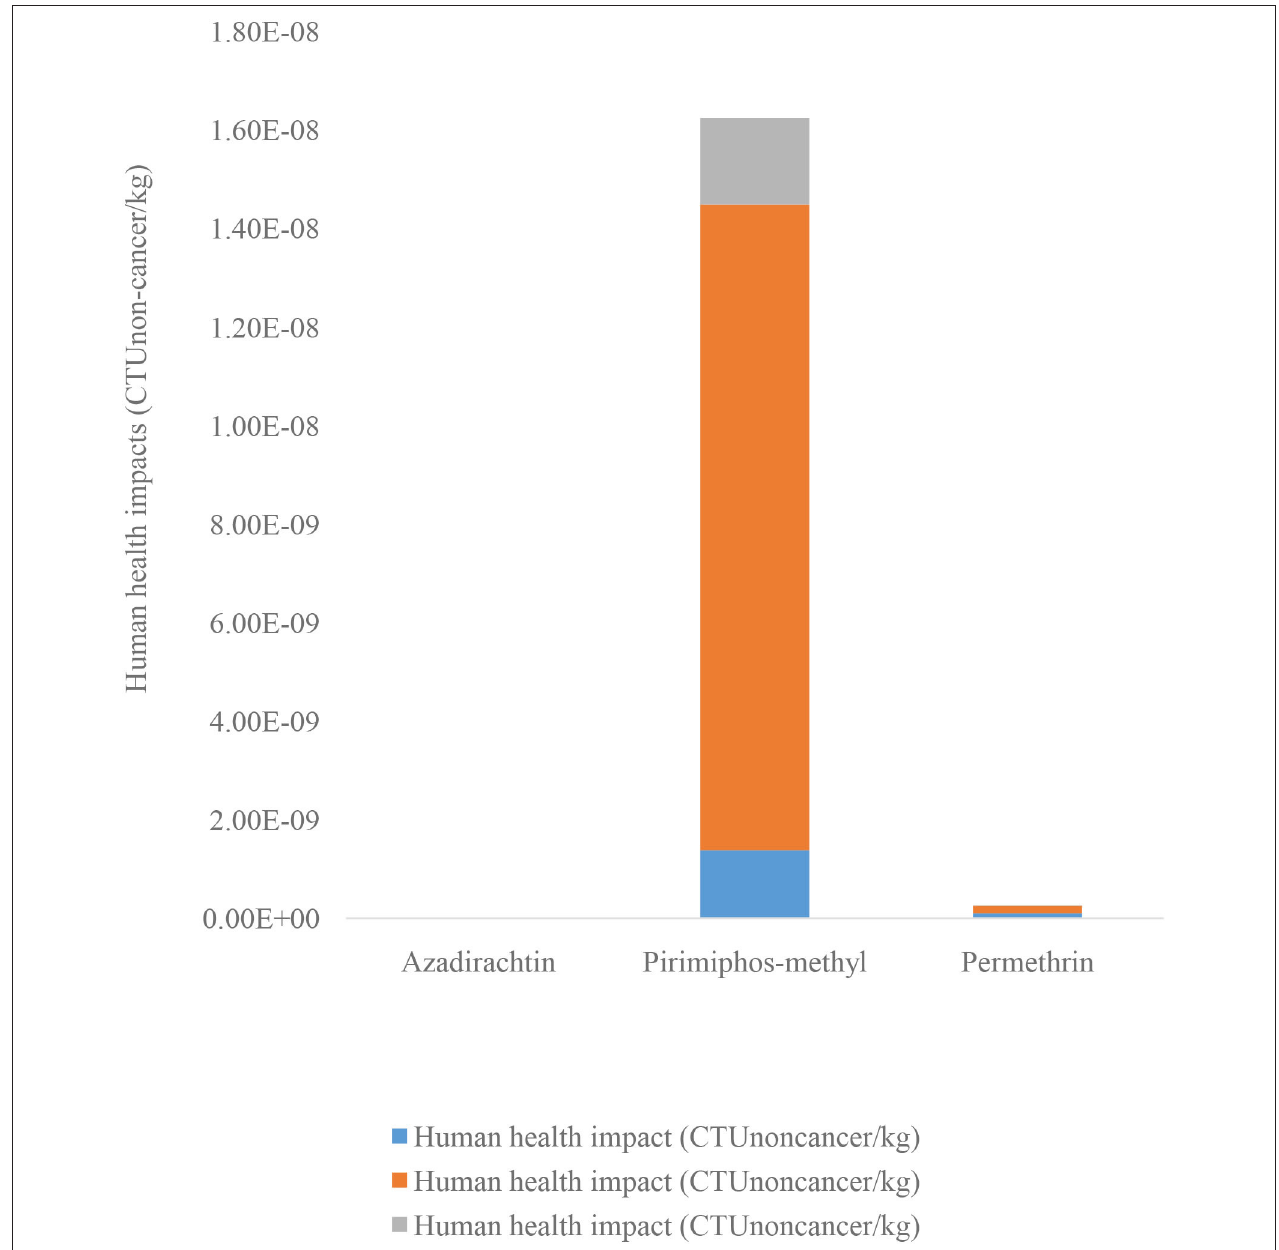
FIGURE 4 | Human health impacts of azadirachtin, pirimiphos-methyl, and permethrin usage on air, water, and soil per 1kg of maize grain (generated using TRACI database, version 2.1,